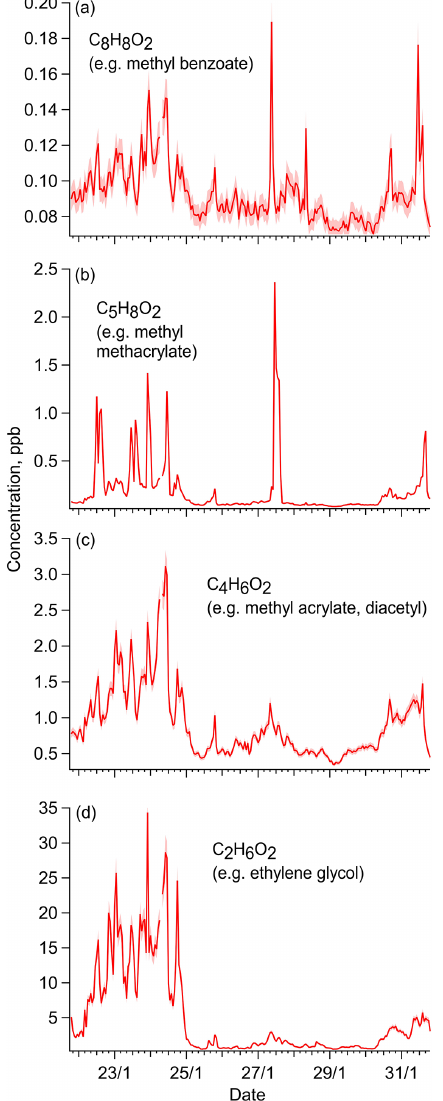
Figure 5. Concentration time series of select prominent ions that include contributions from major VCP-related compounds (exam- ples listed; see Tables 1 and S7 for expanded